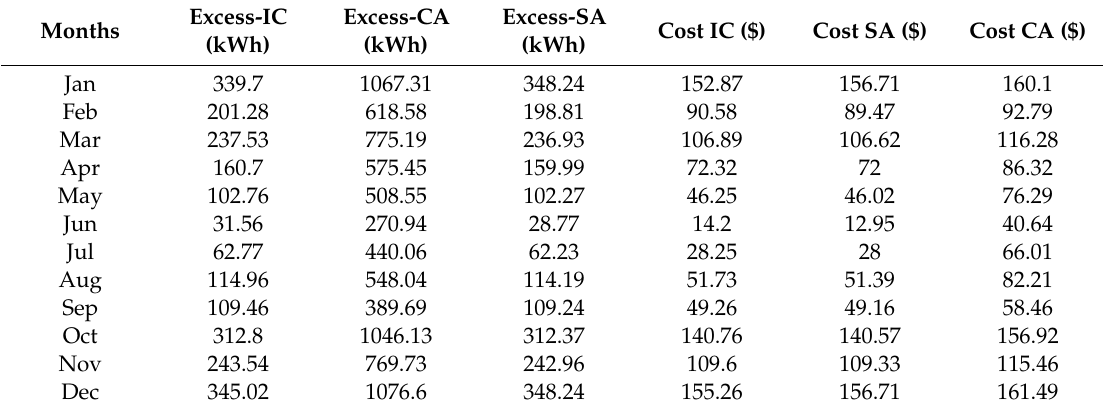
Table A4. Total monthly excess energy and costs obtained from three strategies at Gen Y.